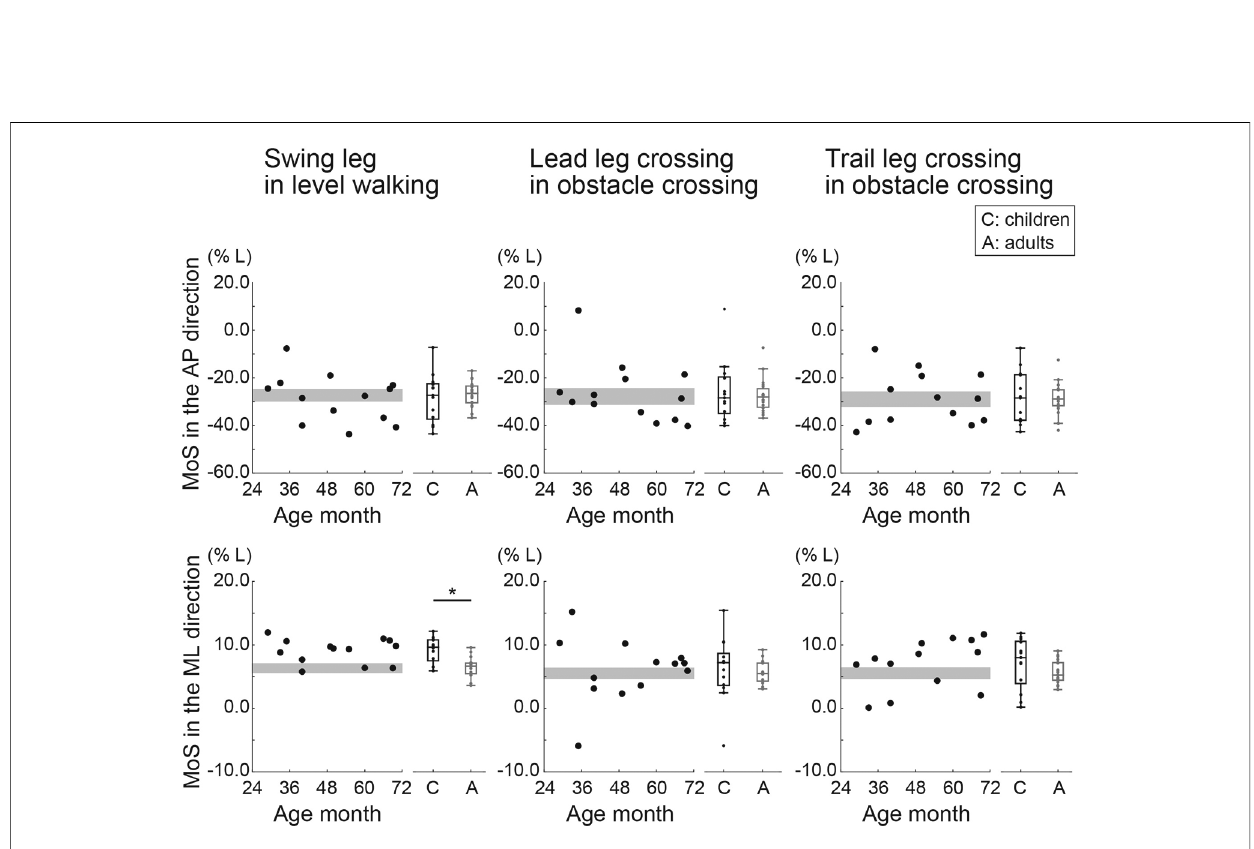
FIGURE 5 Normalized margin of stability (MoS) in the anteroposterior (AP) and mediolateral (ML) directions during level walking and crossing an obstacle (with the lead and trail leg, separately). The MoS was normalized to leg length ( L ). Circles indicate the mean value of within participants. The gray area shows the 95% con fi dence interval (CI) of the mean of adults. * Indicates p